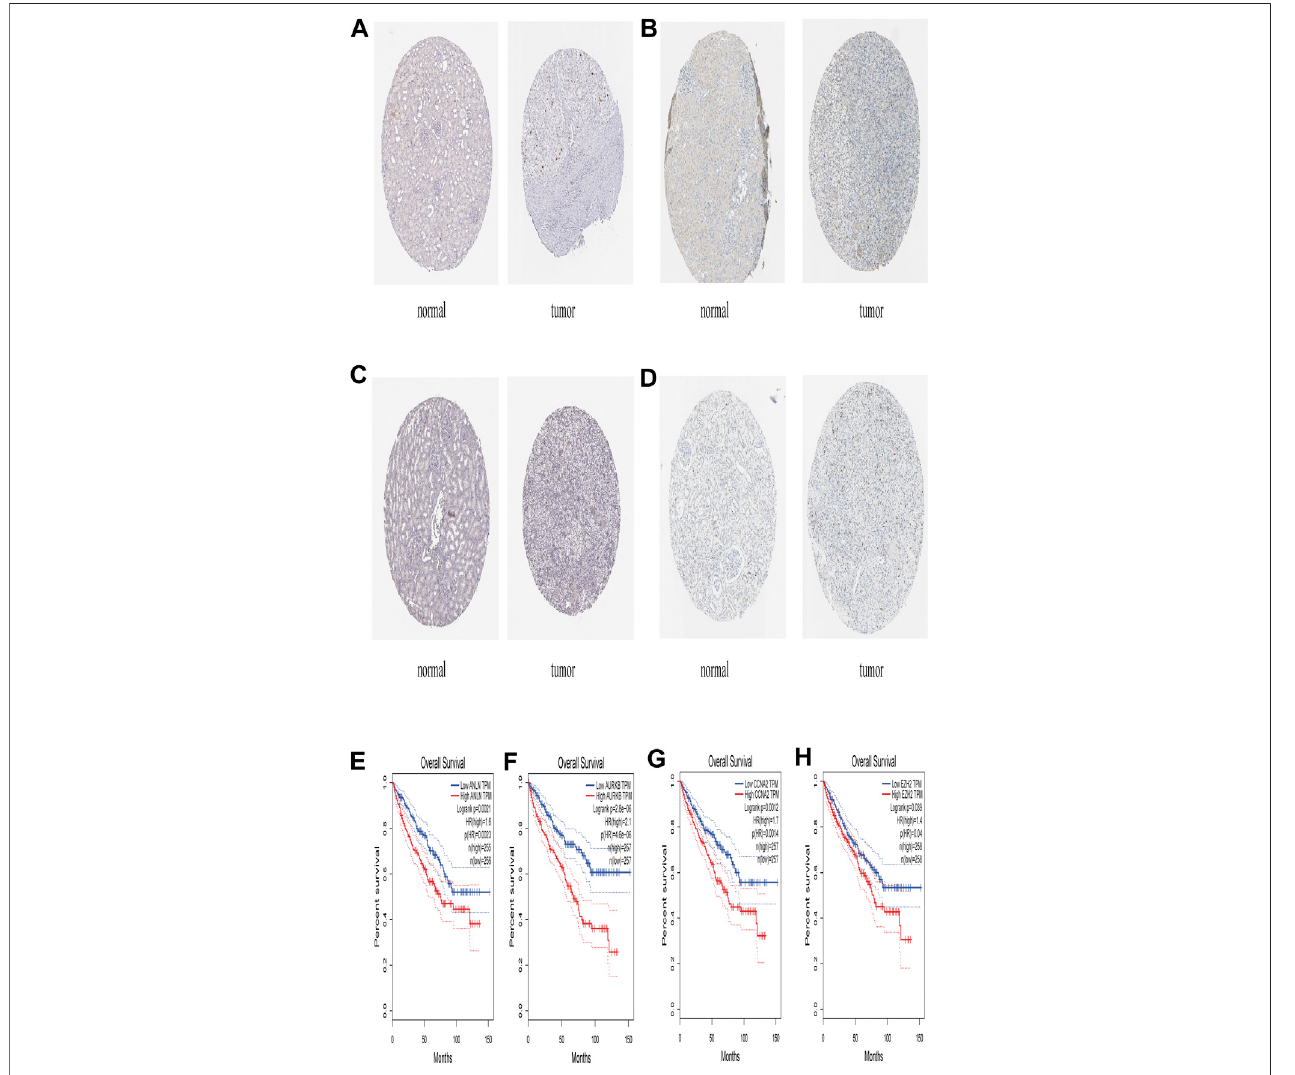
FIGURE6| Theexpression levelofANLN,AURKB,CCNA2,EZH2inTheHuman ProteinAtlasanditsPrognosticvalue (A) Immunohistochemistry resultsofANLN in normal tissues (Staining: Low; Intensity: Weak; Quantity: 75 – 25%; Location: Nuclear) and in ccRCC tissues (Staining: Medium; Intensity: Strong; Quantity: ＜ 25%; Location: Nuclear) (B) Immunohistochemistry results of AURKB in normal tissue (Staining: Not detected; Intensity: Negative; Quantity: None; Location: None) and in ccRCC tissue (Staining: Medium; Intensity: Strong; Quantity: ＜ 25%; Location: Nuclear) (C) Immunohistochemistry results of CCNA2 in normal tissues (Staining: Not detected; Intensity: Negative; Quantity: None; Location: None) and in ccRCC tissues (Staining: Medium; Intensity: Strong; Quantity: ＜ 25%; Location: Nuclear) (D) Immunohistochemistry results of EZH2 in normal tissues (Staining: Not detected; Intensity: Negative; Quantity: None; Location: None) and in ccRCC tissues (Staining: Low; Intensity: Moderate; Quantity: ＜ 25%; Location: Nuclear) (E) Prognostic value of AURKB (F) Prognostic value of AURKB (G) Prognostic value of CCNA2 (H) Prognostic value of